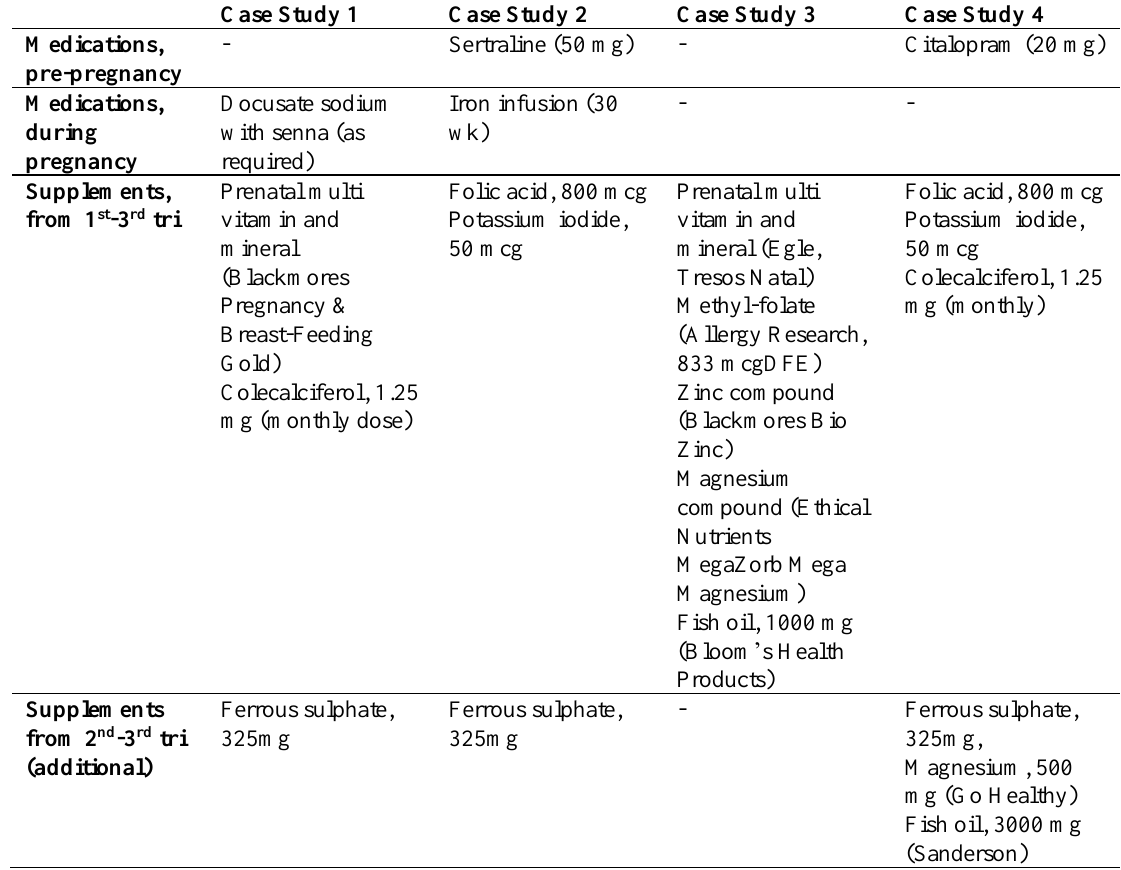
Table 3-A1. Medications and nutritional